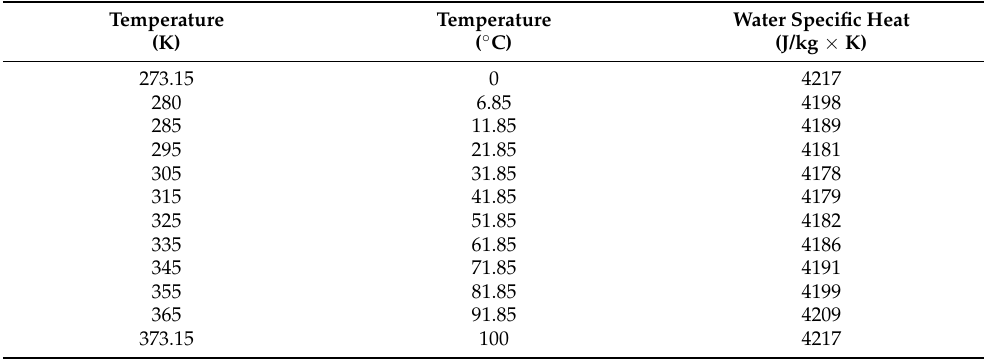
Table 6. Water-specific heat as a function of